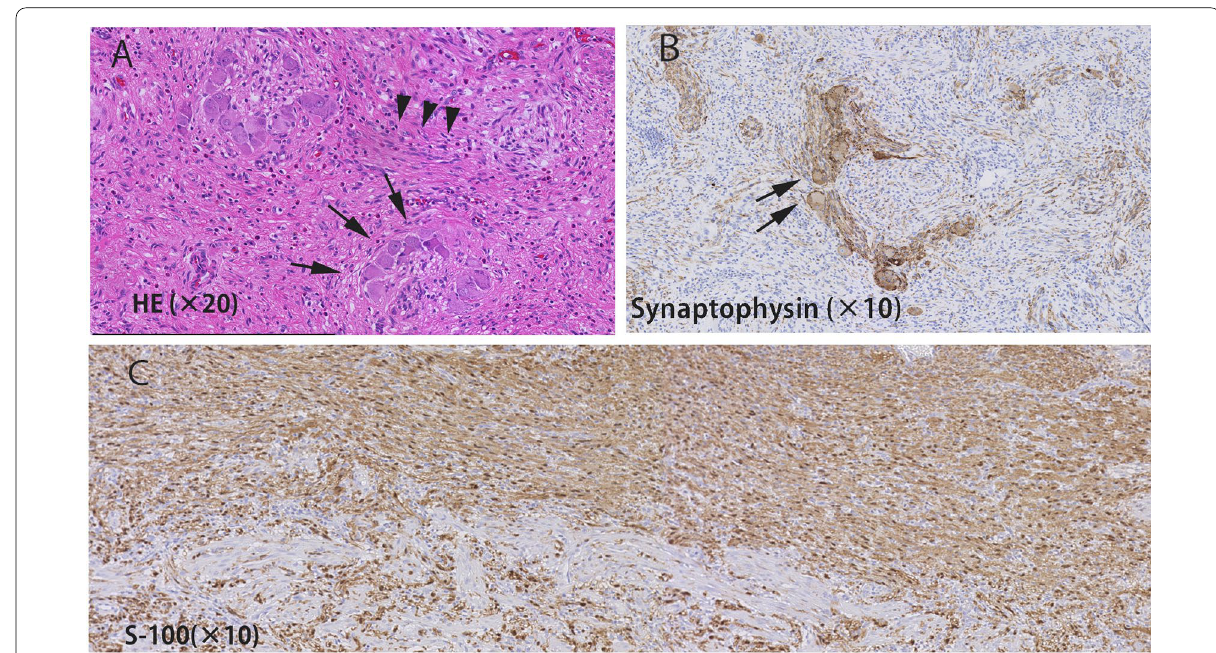
Fig. 3 A Short spindle-shaped cells (neuron component: arrow heads) and round-shaped cell (ganglion cell: arrows) diffusely infiltrated the proper muscle layer, and fibrous tissue had grown around the nerve cells. B , C According to immunostaining, ganglion cells were positive for both S-100 C and synaptophysin ( B ), and neurons were positive for S-100 only